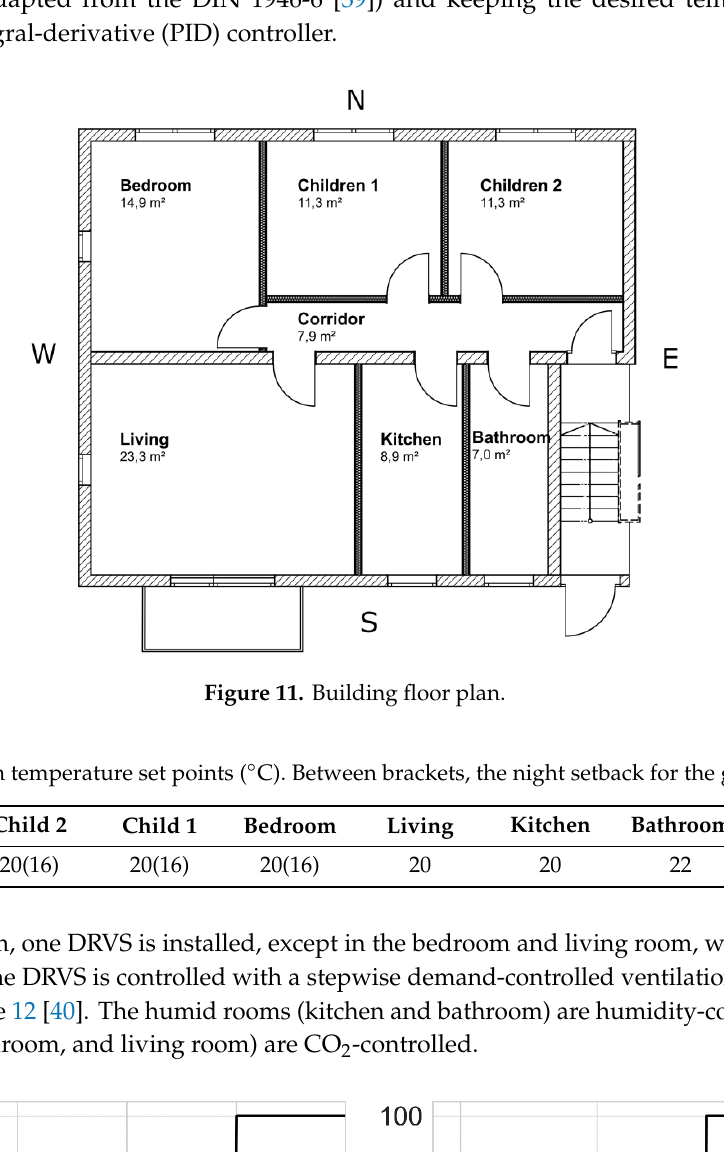
Table 5. Room temperature set points (°C). Between brackets, the night setback for the given rooms.